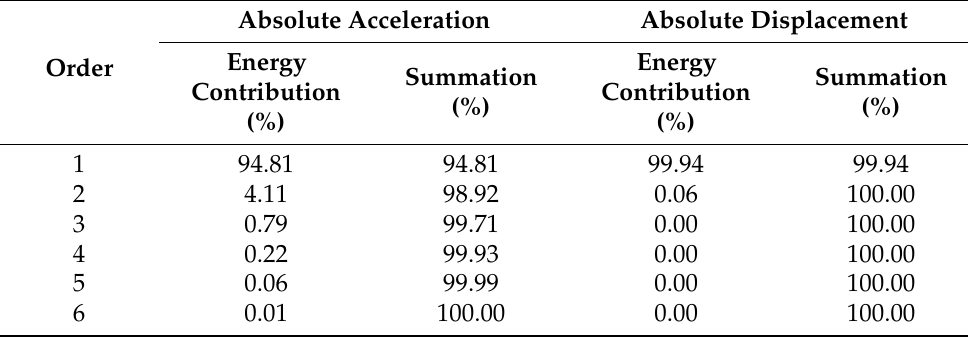
Table 2. Energy contribution of different modes of nine-DOF